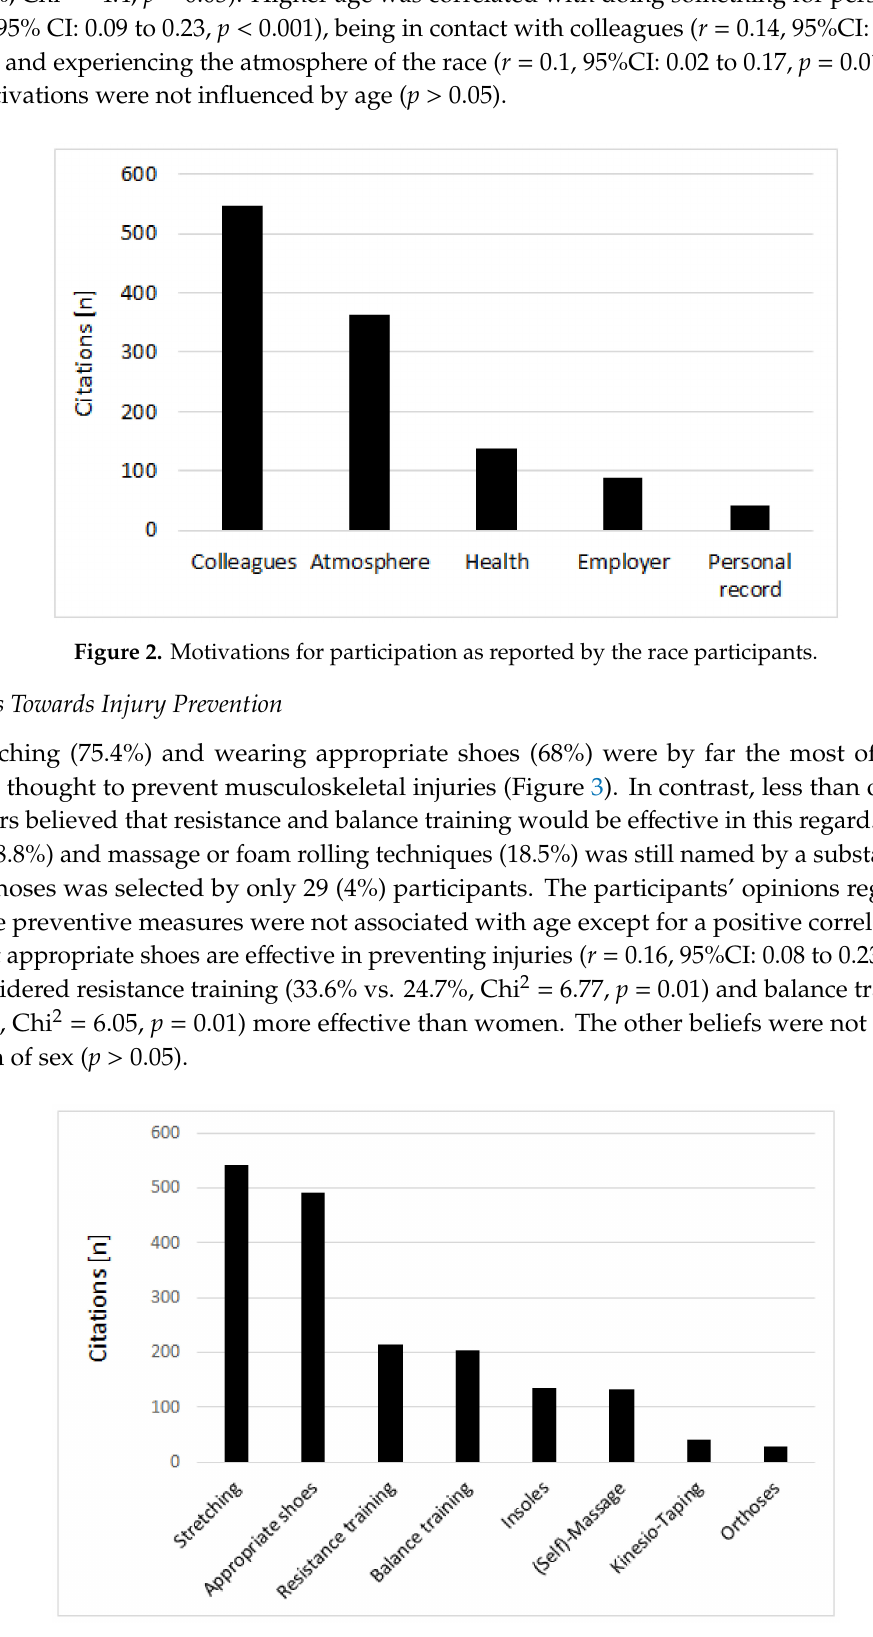
Figure 3. Injury prevention strategies in running as reported by the race